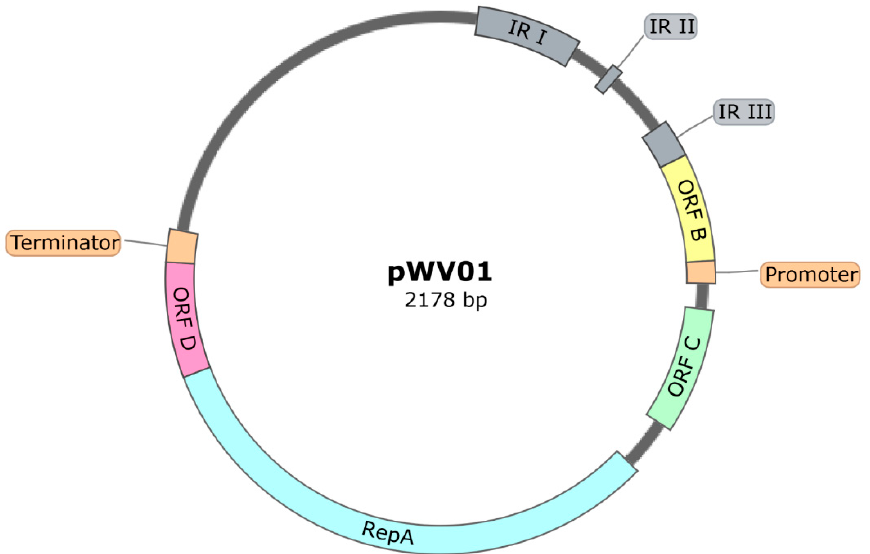
Figure 3. Main features of the plasmid pWV01 replicon. The repA and orfC genes code for the replication initiation protein and for a protein involved in negative copy number control, respectively. The Open Reading Frame ORFD is putatively involved in copy number regulation, but the ORFB function is still not clear. The double-strand origin (DSO) necessary for the rolling-circle (RC) replication process is located in the inverted repeat (IR) III, while the single-strand origin (SSO) is located in the IR I and IR II. Compiled based on data from [62].